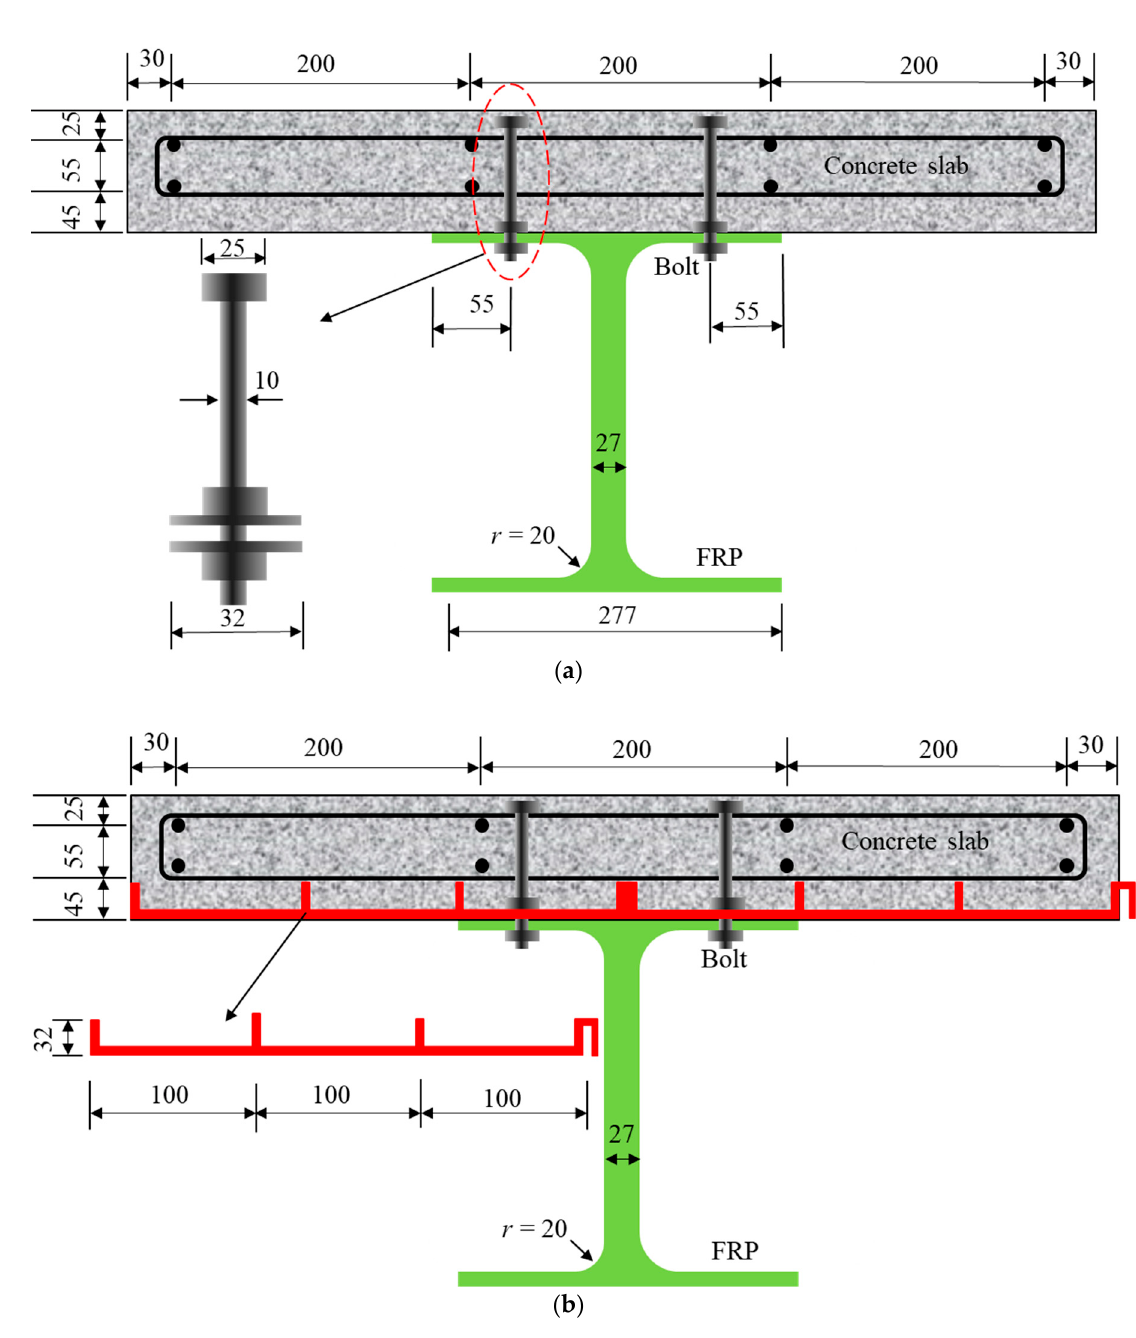
Figure 4. Cross section of ( a ) Beam 1, and ( b ) Beam 2 (units in mm, not to scale).